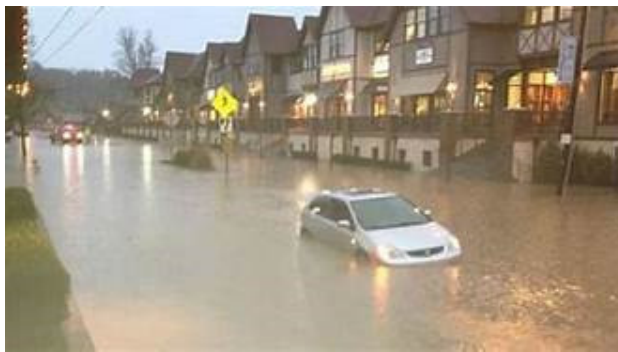
Figure 5. Asheville during the 2022 flood.